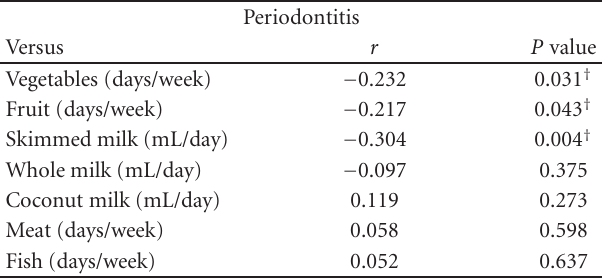
Table 4: Simple correlation coe ffi cients between periodontitis and dietary intakes expressed by the frequency or the